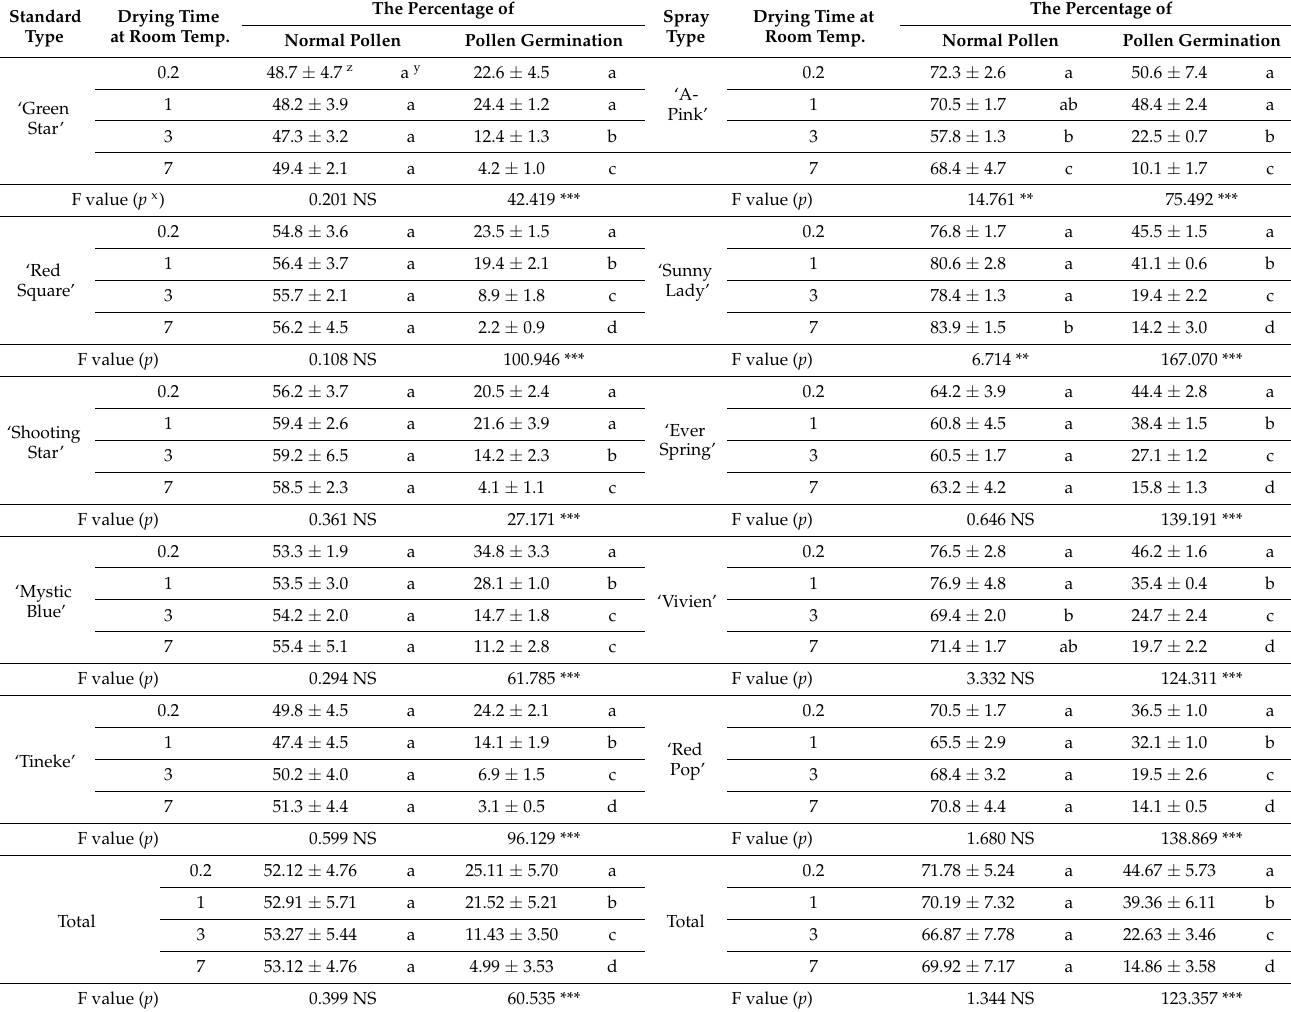
Table 2. Effect of stage period of pollen on morphological condition and germination in five standard- and spray-type cultivars after 0.2, 1, 3, and 7 days